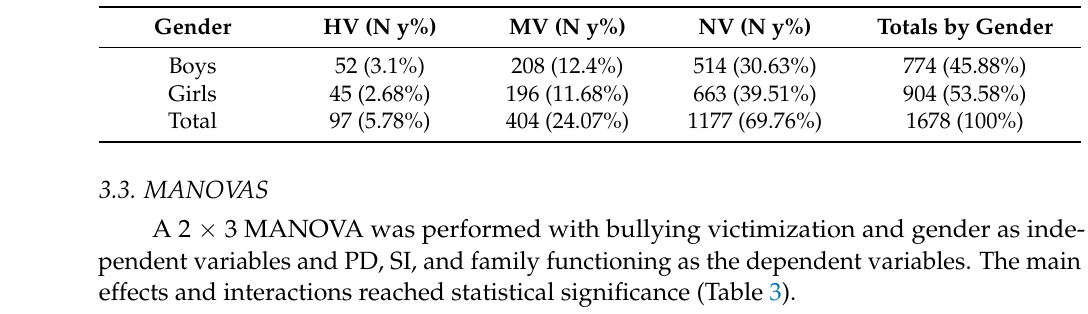
Table 2. Cluster Distribution by Victimization and Gender.